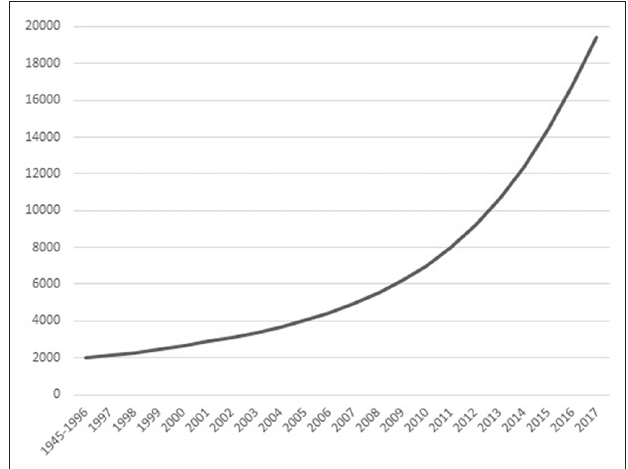
FIGURE 1 | Cumulative number of scientific publications on contemplative activity (ContAct), from the 1945–1996 bracket to 2017 per individual year. Obtained from Web of Science in January 2018 using the search terms: “mindfulness” OR “meditation” OR “yoga” OR “tai